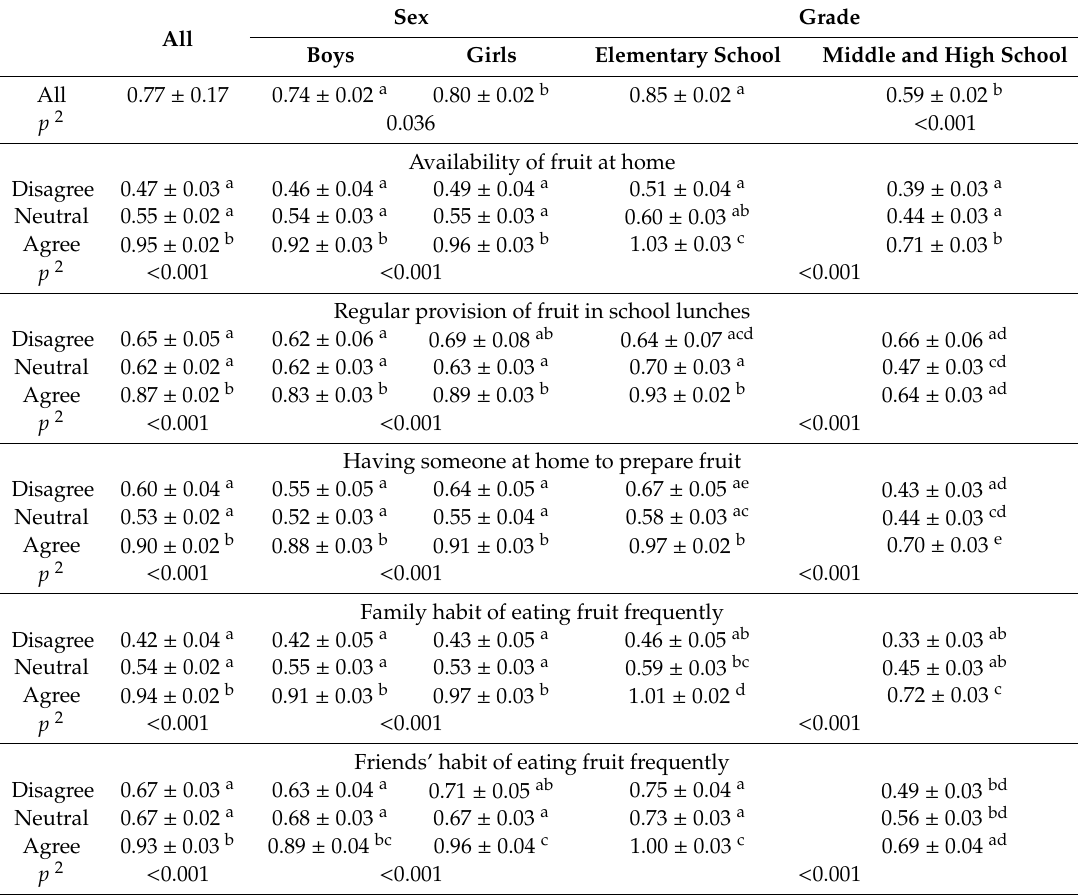
Table 3. Relationship between aspects of participants’ food environments and frequency of fruit intakes 1 .